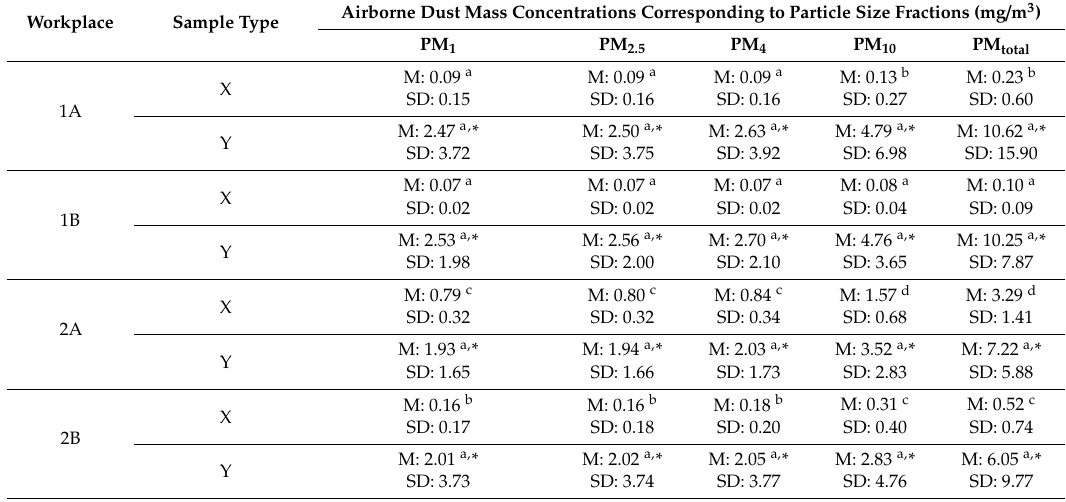
Table 5. Airborne dust mass concentrations at